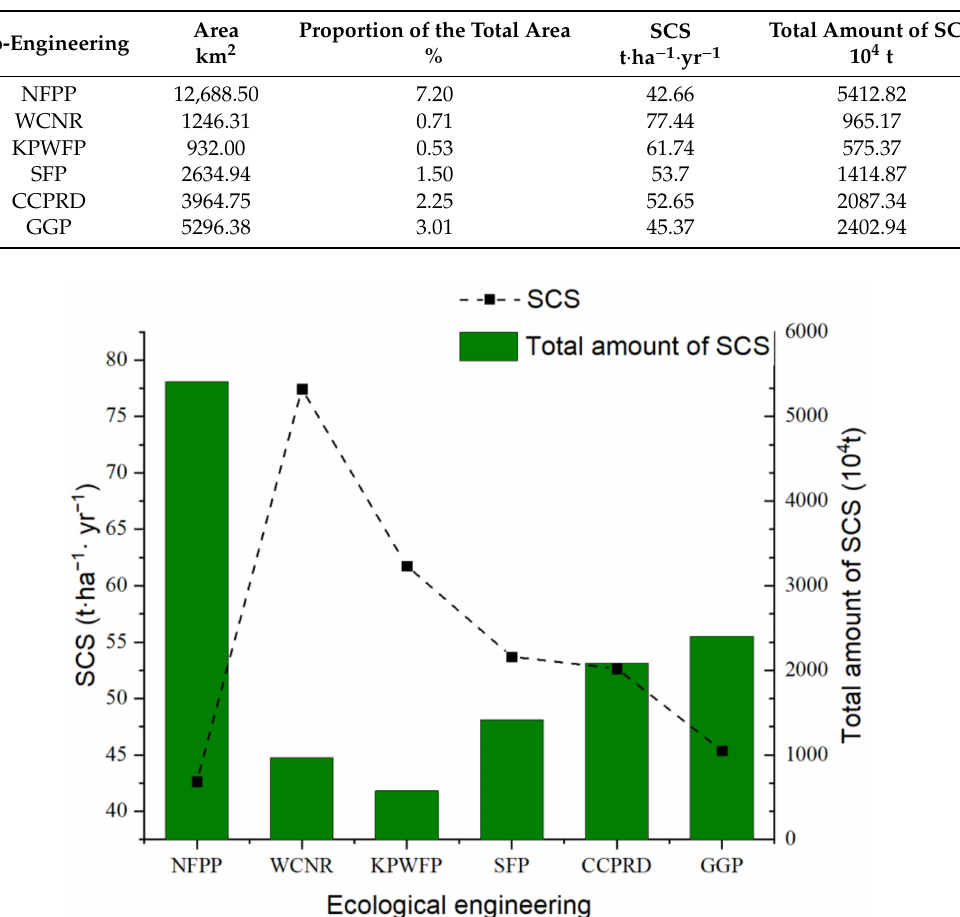
Table 4. Area and SCS of di ff erent ecological engineering projects on the Guizhou Plateau.